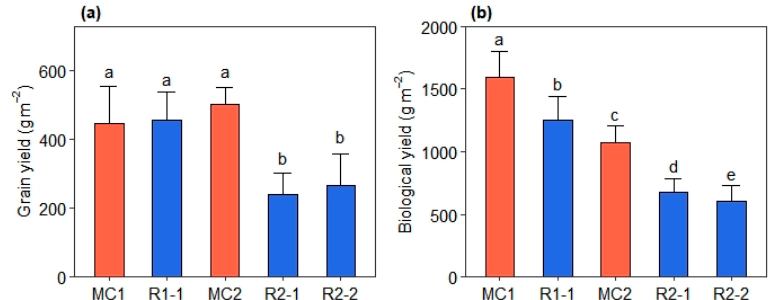
Figure 4. Comparison of grain yield ( a ) and biological yield ( b ) are described in order of cropping. Ratoon crops were cultivated under different cutting and moisture regimes. MC1 and MC2 represent the first and second main crop, respectively. R1-1, R2-1, and R2-2 indicate first ratoon of MC1 and first and second ratoons of MC2, respectively. Data are means ± standard error, sample size n = 24. Same letters above the bar did not significantly differ at the 5% level by Tukey’s honestly significant difference (HSD) test.